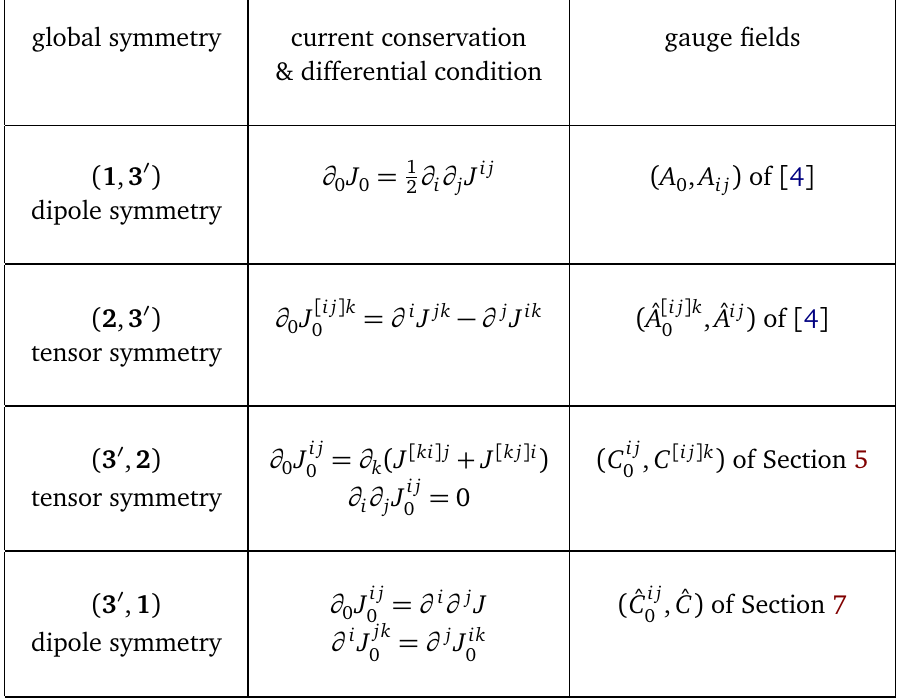
) for the representations ( R , R 4 time space